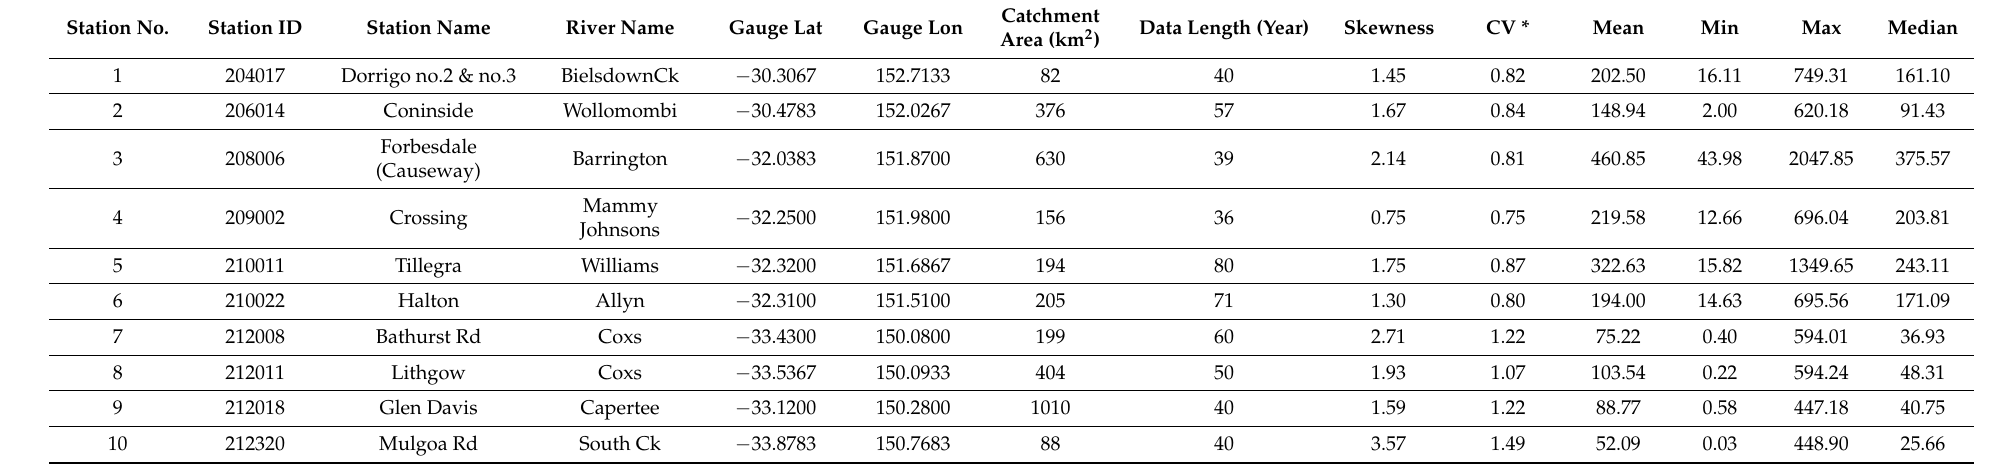
Table 1. Physical properties and data length for the selected stream-gauging stations * CV stands for co-efficient of variation . Station